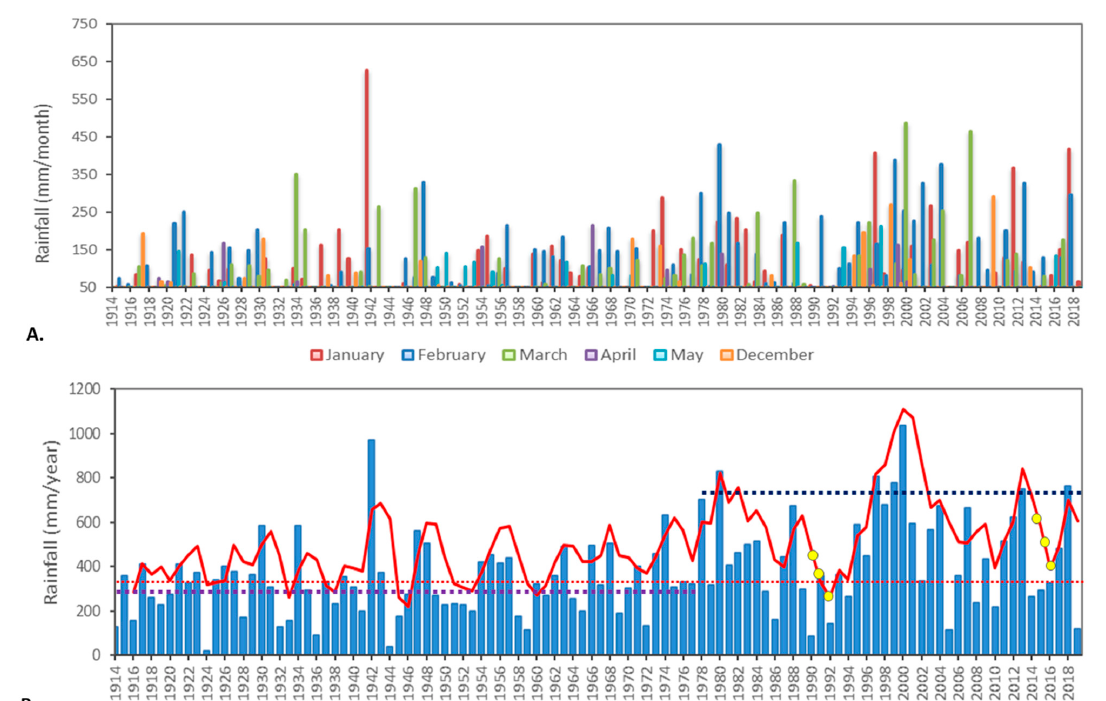
Figure 2. Climate data from Mandora Bureau of Meteorology Station (BOM) No. 0419 (http://www.bom.gov.au/climate/data accessed on: 24 March 2021): ( A ). Bar graph of monthly wet season rainfall (1914 to 2019); ( B ). Bar graph of annual rainfall (1914 to 2019), with three-point moving average shown as a red solid line; mean annual rainfall for different periods (1914–2019: red dashed line @ ~377 mm; 1914–1977: purple dashed line @ ~320 mm; 1978–2019: blue dashed line @ ~463 mm) and yellow dots represent decreasing average rainfall trends at the end of the two climate cycles that are examined in this study.